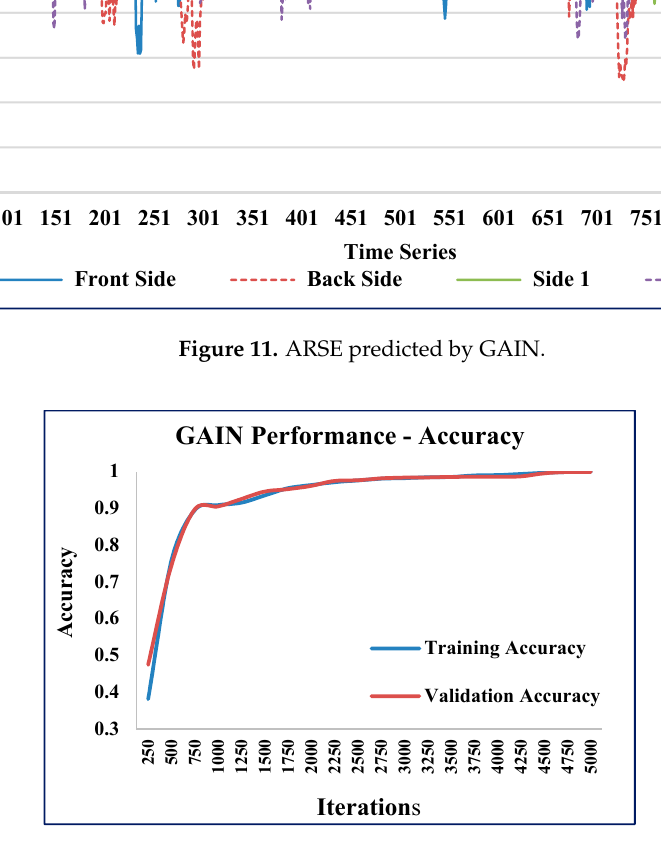
Figure 12. GAIN accuracy measure.